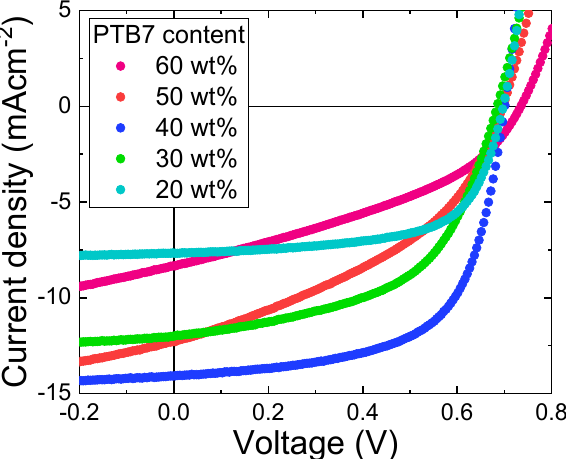
Figure 3. Current density–voltage (J–V) characteristics of PTB7:PC 71 BM inverted OPVs with different PTB7 content under 100 mWcm − 2 AM1.5G irradiation at room temperature.